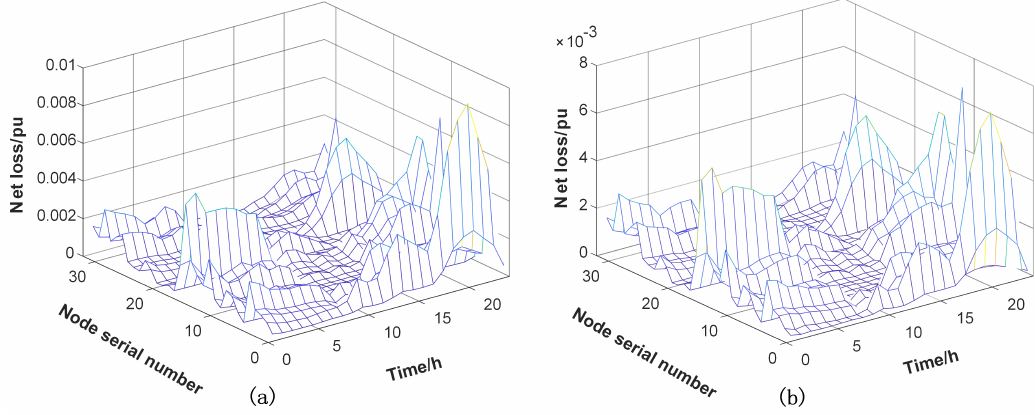
Fig. 15. Comparison diagram of network loss before and after regulation